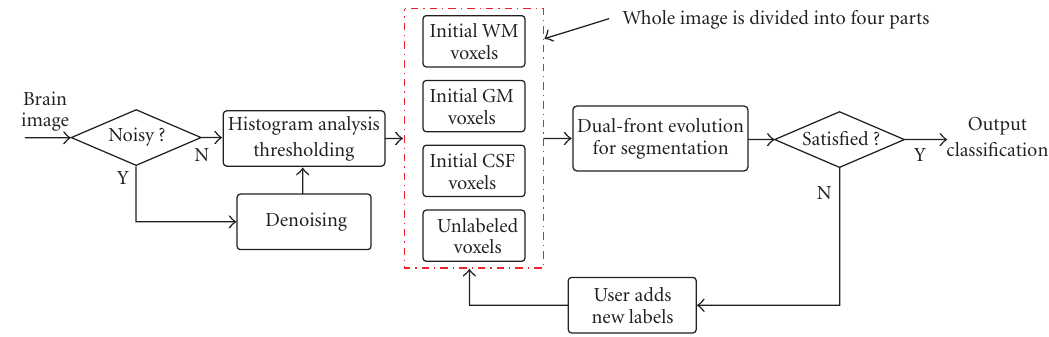
Figure 6: Overall diagram of 3D brain cortex segmentation